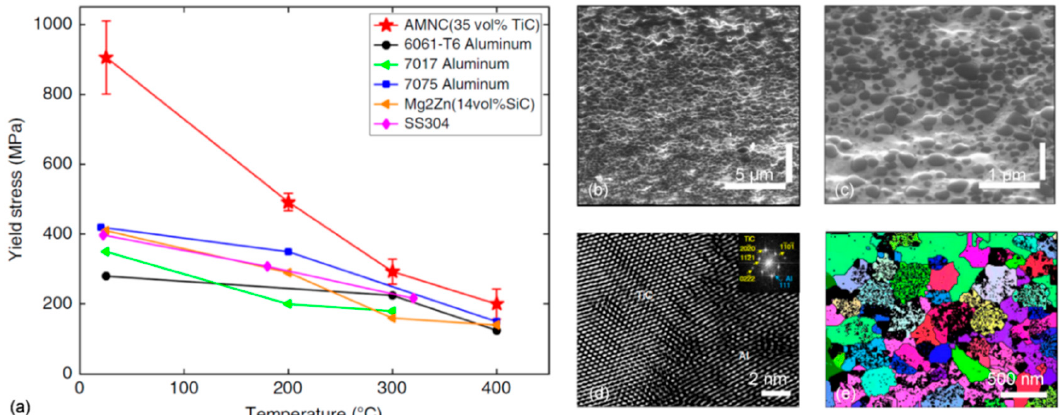
Figure 30. Mechanical behavior and microstructure of laser-deposited Al − matrix nanocomposites (AMNC) at elevated temperature: ( a ) yield strength of nanocomposite (35 vol.% TiC) at 25, 200, and 400 °C in comparison with other materials; ( b , c ) SEM images showing TiC nanoparticles uniformly distributed in matrix; ( d ) FFT-filtered high-resolution TEM image showing good bonding between TiC nanoparticle and Al; ( e ) grain map showing orientation distribution [140].